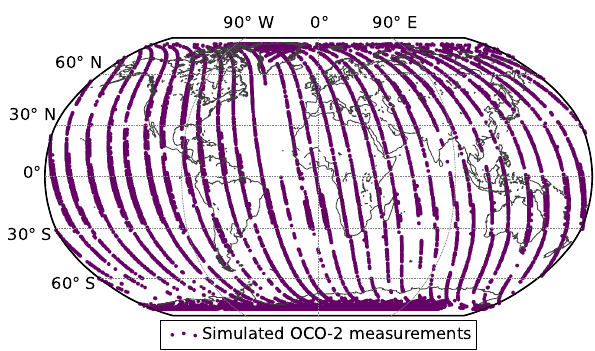
Figure 2. Global distribution of the 44000 simulated OCO-2 mea- surements.